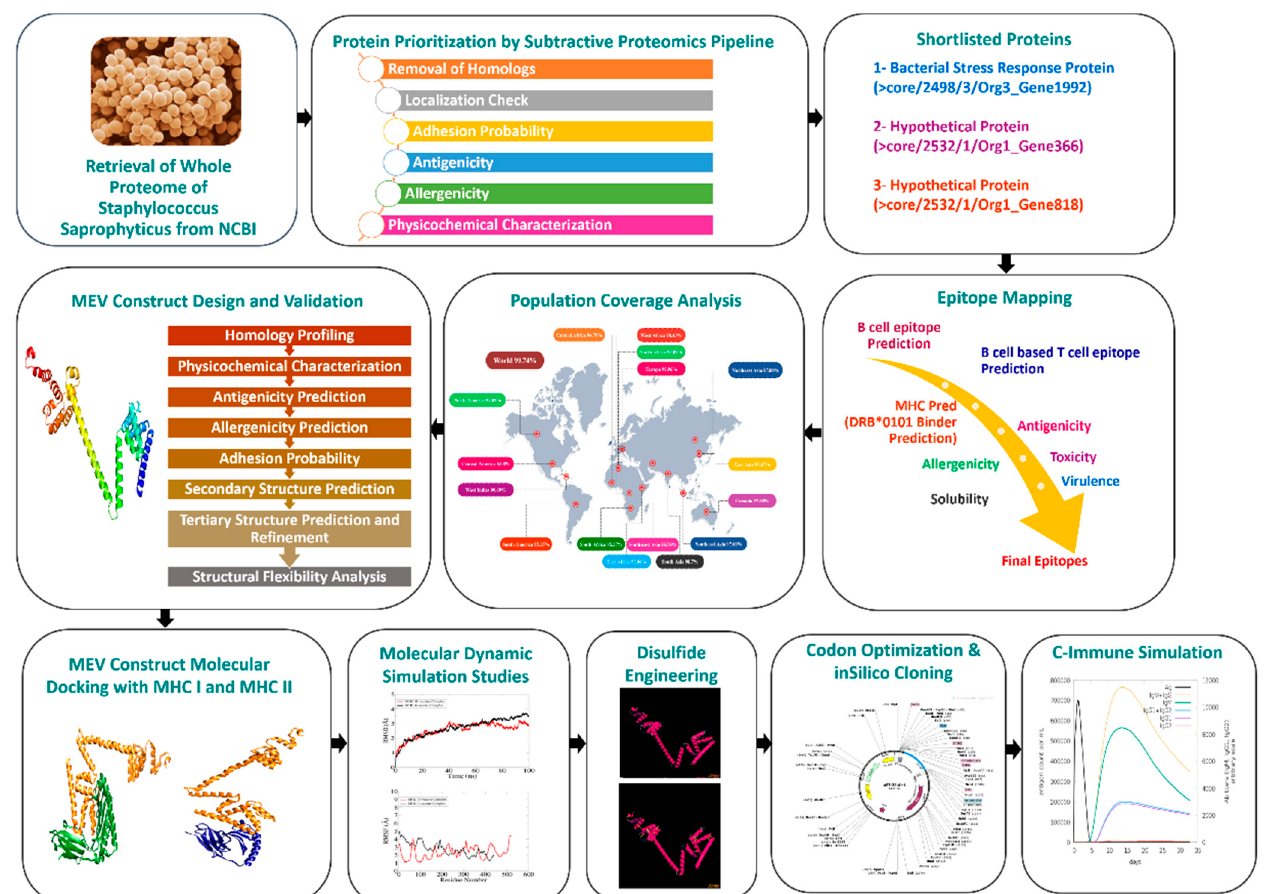
Figure 1. Schematic illustration of the steps involved in methodology of this research.